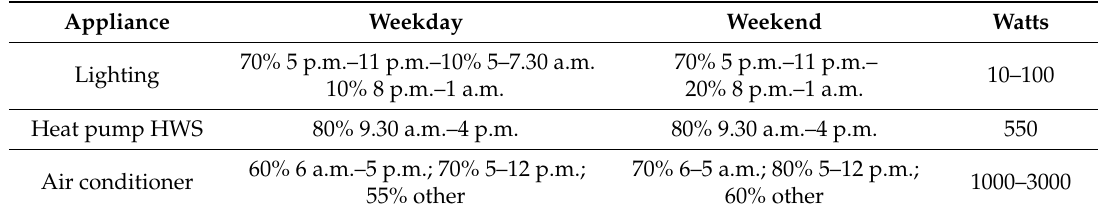
Table 4. Major load variations in winter .